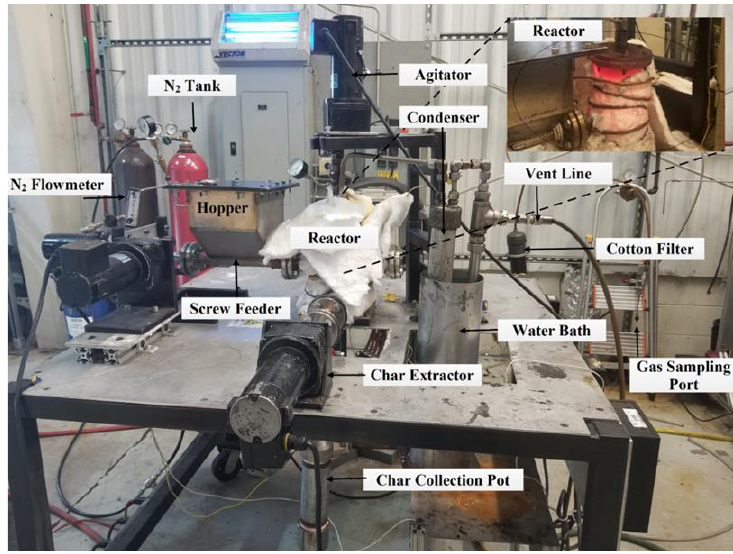
Figure 1. Bench-scale MFR and the main reactor (top-right corner).